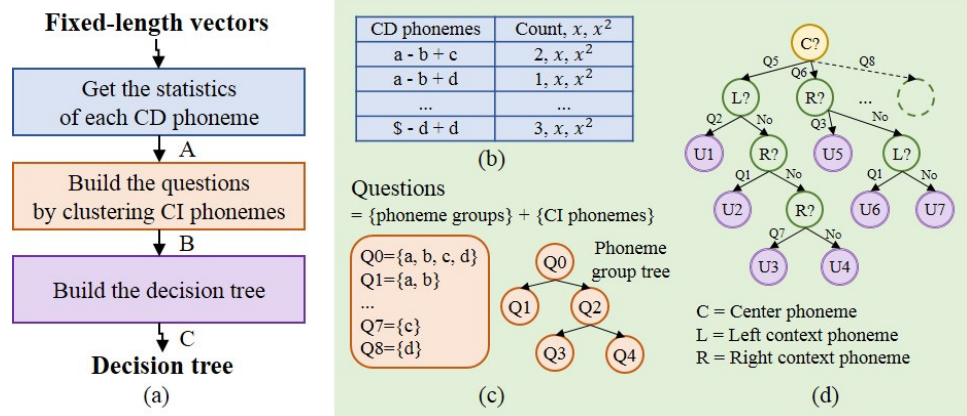
Figure 3. Block diagram and a simple example of decision tree-based clustering. ( a ) Block diagram of the decision tree-based clustering; ( b ) statistical table obtained at point A; ( c ) questions obtained at point B; ( d ) decision tree obtained at point C.